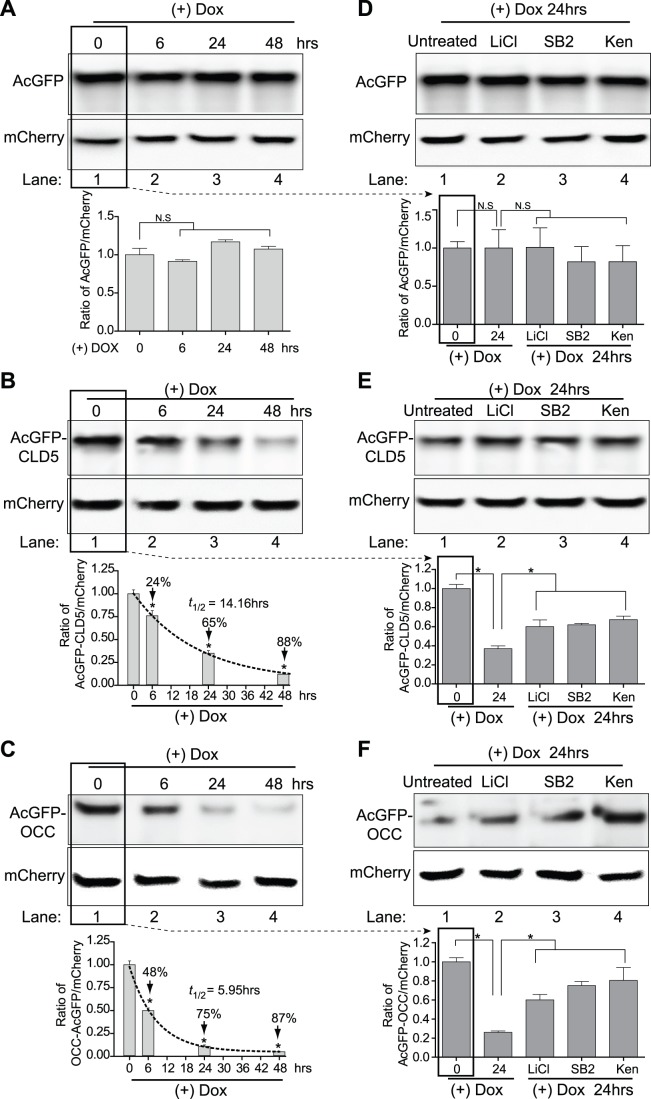
Evaluation of TJ protein stability with GSK3β inhibitors in HEK293 cells.Panels A-F show western blots of HEK293 cells expressing the tight junction protein stability system after treatment with doxycycline to turn off transgene expression. The cells were monitored at 0, 6, 24 and 48 hr, lysed and western blots were probed for GFP and mCherry. (A) The expression of unfused AcGFP is shown by densitometry analysis. (B and C) The fused AcGFP-CLD5 and AcGFP-OCC protein degradation is shown as a function of time. The values in the graph represent the densitometric values from the ratio of fused protein to mCherry normalized against the zero time point. To determine the protein turnover half-life, the values were fitted to first order kinetics (dashed line). The results are shown as the mean+SEM (n = 3). (*) denote a difference of P<0.05 between the groups compared (bracket) or to the zero time point. The effect of GSK3β inhibitors LiCl (10 mM), SB216763 (SB2, 20 µM), kenpaullone (Ken, 2 µM) on AcGFP, AcGFP-CLD5 and AcGFP-OCC expression are shown in panels D-F, respectively. After addition of Dox for 24 hr, the cells were lysed and western blots for GFP were performed. Basal turnover is shown in lane 1; the inhibition in tight junction protein turnover resulting from GSK3β inhibition is shown observed in lanes 2–4. The graphed densitometric values were calculated using the ratio of AcGFP to mCherry with normalization to fold change. Note: the densitometry shows the time zero reference which is not shown in the blots (see B and C). The results are shown as the mean ± SEM (n = 3), * denotes a difference of P<0.05 between the groups compared (bracket).